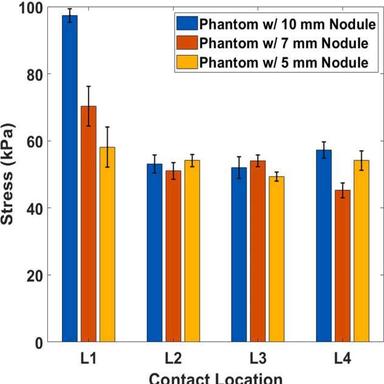
Static stress at different locations of the prostate phantom during palpation experiments using the test rig and compression procedure seen in. Compression was performed at the indentation depth of 5 mm and at a rate of 10 mm/s following the indentation profile depicted in a. 95% confidence interval are represented by the error bars.